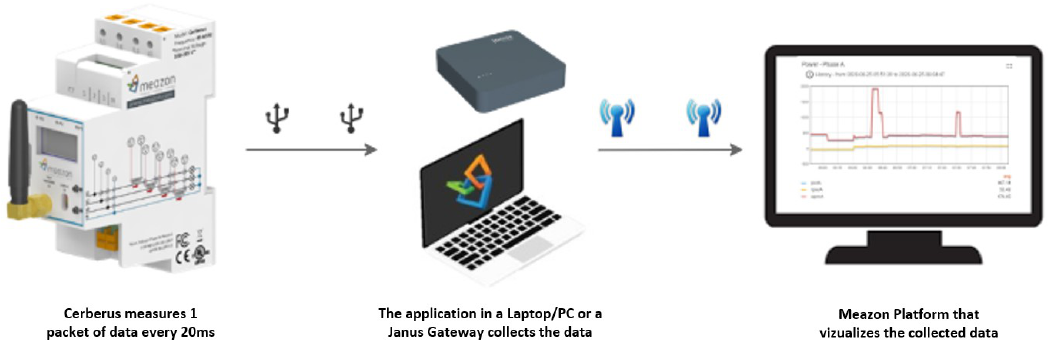
Figure 2. Data flow from the smart meter to the user’s